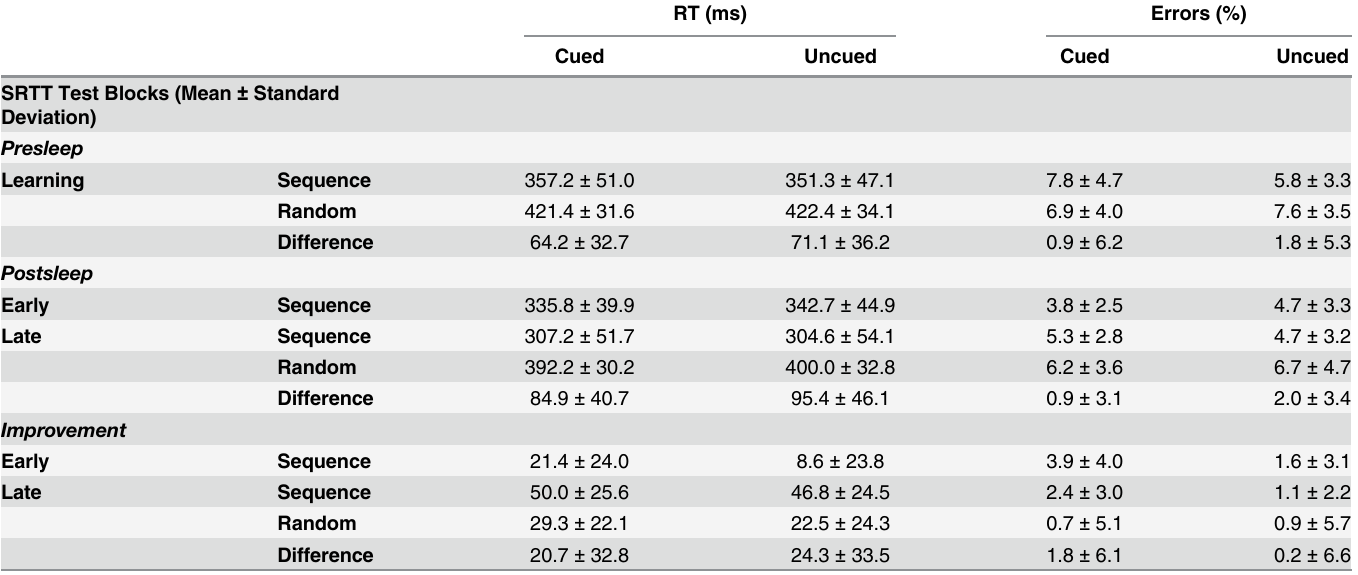
Table 1. RT and accuracy scores for cued and uncued sequence performance.